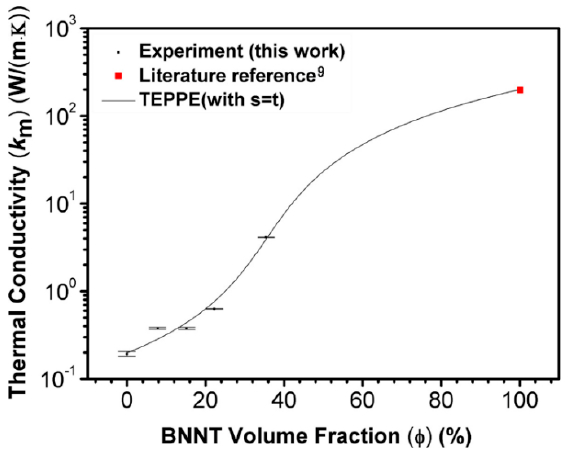
Figure 6. Influence of boron nitride nanotubes (BNNTs) content on thermal conductivity of PDCs [41]. Reproduced with permission from Xu C., J. Am. Ceram. Soc.; published by Wiley, 2019.